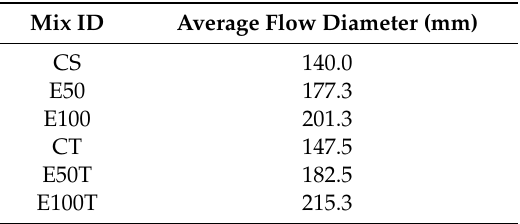
Table 4. Flow results of